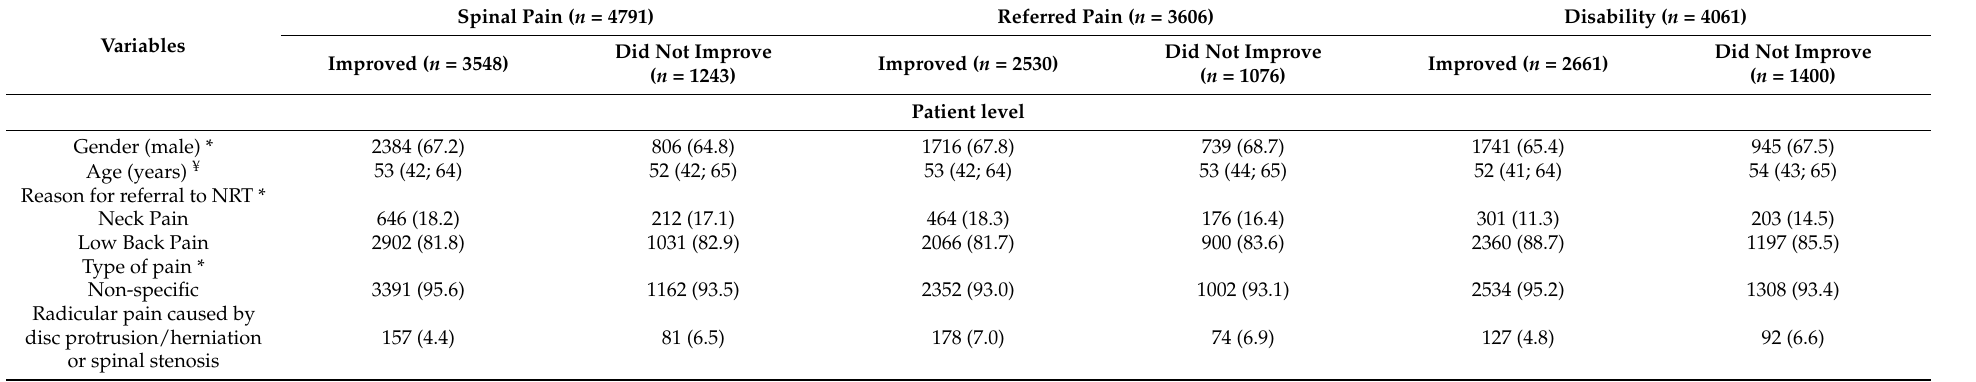
Table 2. Characteristics of patients who showed and did not show clinically relevant improvements in SP, RP, and disability, after